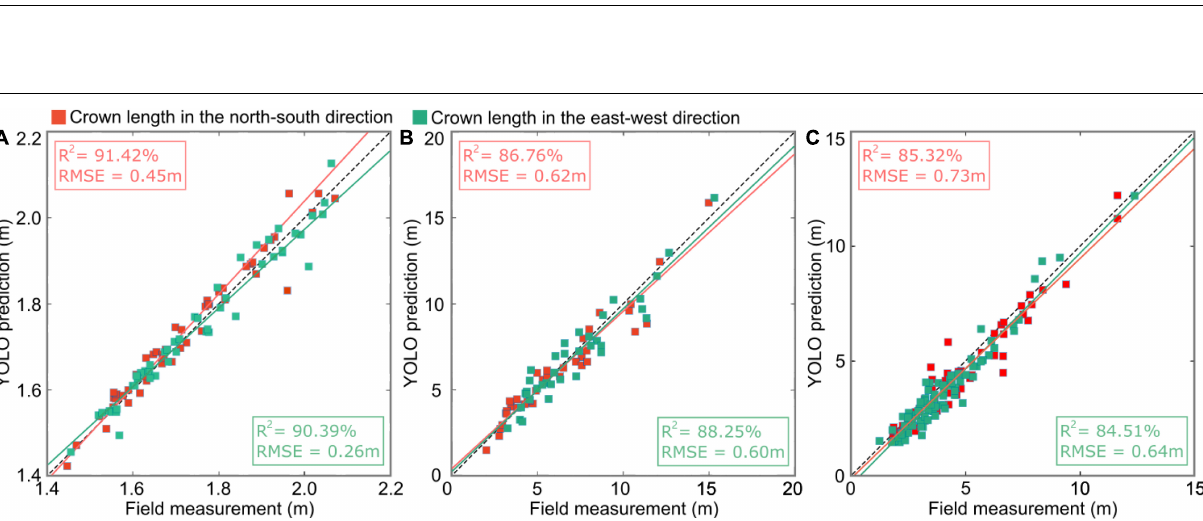
Frontiers in Plant Science |